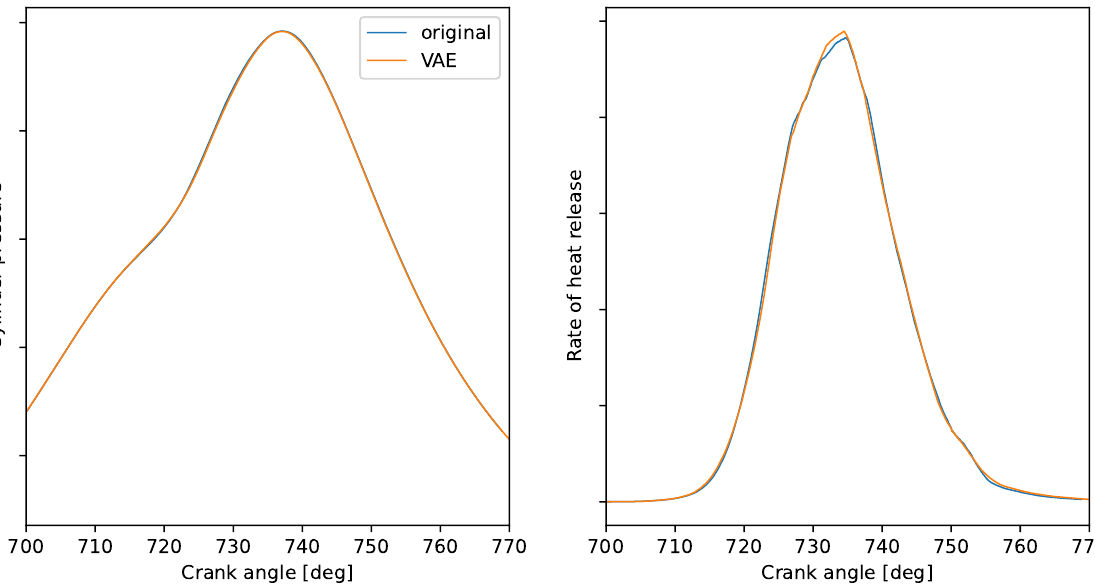
Figure 7. In-cylinder combustion process results started with the original and the VAE reconstructed velocity and TKE